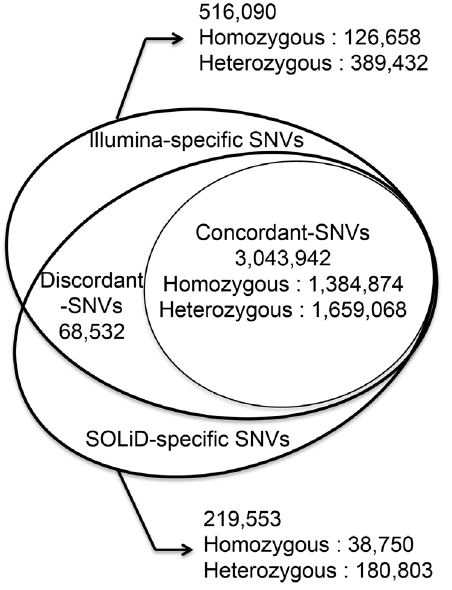
Figure 1. Concordance of SNVs identified by the two different sequencing